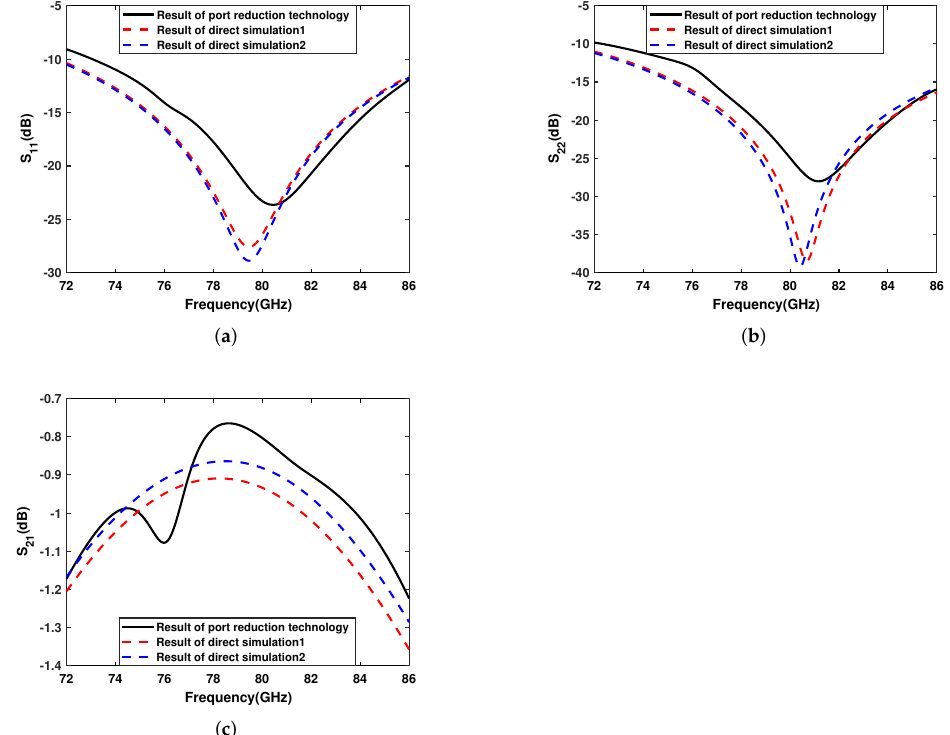
Figure 15. Comparison of the package-board transition results calculated by the port reduction method and the direct simulation results. ( a ) S 11 , ( b ) S 22 , ( c ) S 21 /S 12